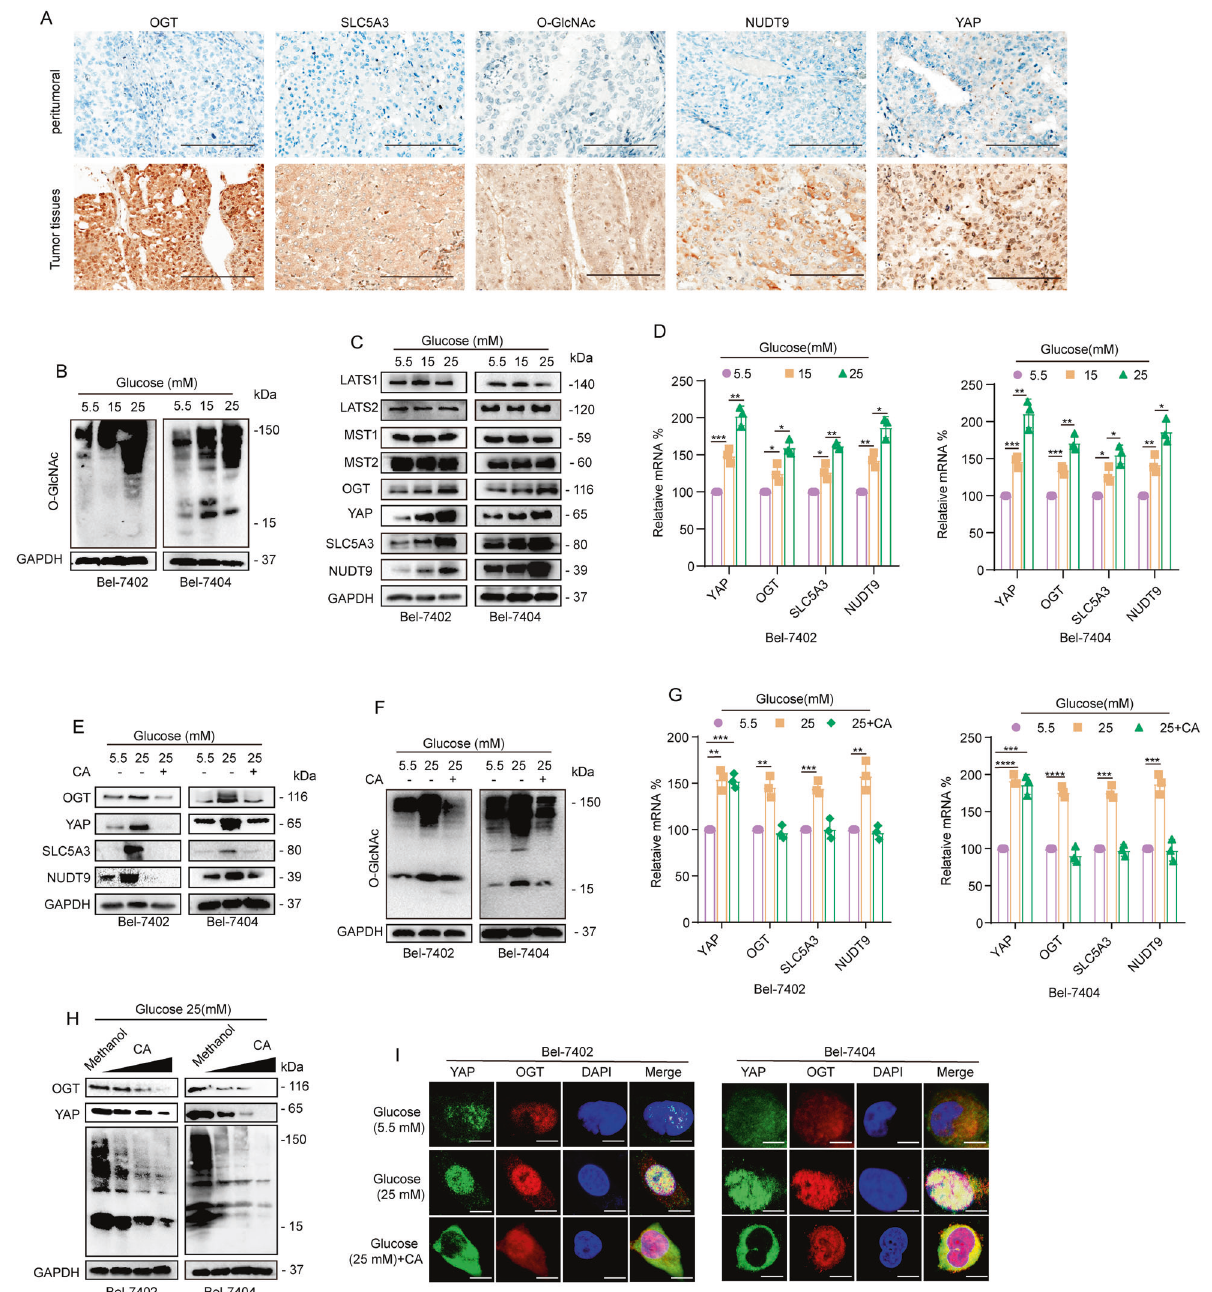
Fig. 2 A Representative images of IHC staining of YAP, OGT, O -GlcNAc, SLC5A3, and Nudt9 in liver cancer and peritumoral tissues. Scale bar, 100 μ m. Liver cancer and normal liver tissue samples were paired. B , C WB analysis of O -GlcNAc levels ( B ) and LATS1, LATS2, MST1, MST2, OGT, YAP, SLC5A3, and Nudt9 ( C ) expression in Bel-7402 and Bel-7404 cells cultured in media containing the indicated concentrations of glucose for 24 h. D YAP, OGT, Nudt9, and SLC5A3 were analyzed by qPCR in Bel-7402 or Bel-7404 cells under the indicated treatments. E , F LATS1, LATS2, MST1, MST2, O -GlcNAc, Nudt9, and SLC5A3 were analyzed by WB. G YAP, OGT, Nudt9, and SLC5A3 were analyzed by qPCR in Bel-7402 or Bel- 7404 cells. H Representative WB images of YAP, OGT, O -GlcNAc, and GAPDH in Bel-7402 and Bel-7404 cells (treated with 1 – 40 μ M CA). I Subcellular localization of YAP and OGT in Bel-7402 and Bel-7404 cells cultured in 5.5 mM glucose or 25 mM glucose or treated with the same amounts of methanol and CA ( fi nal concentration of 40 μ M). Scale bars: 20 μ m. Data are shown as the mean ± SD. * P < 0.05, ** P < 0.01, *** P < 0.001, **** P <